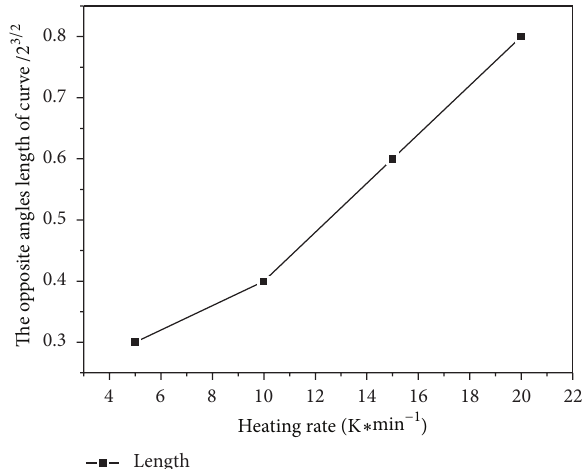
Figure 11: Comparison between the measured and model calculated resultsonreactionfractionofthereductionphase(prereductionand final